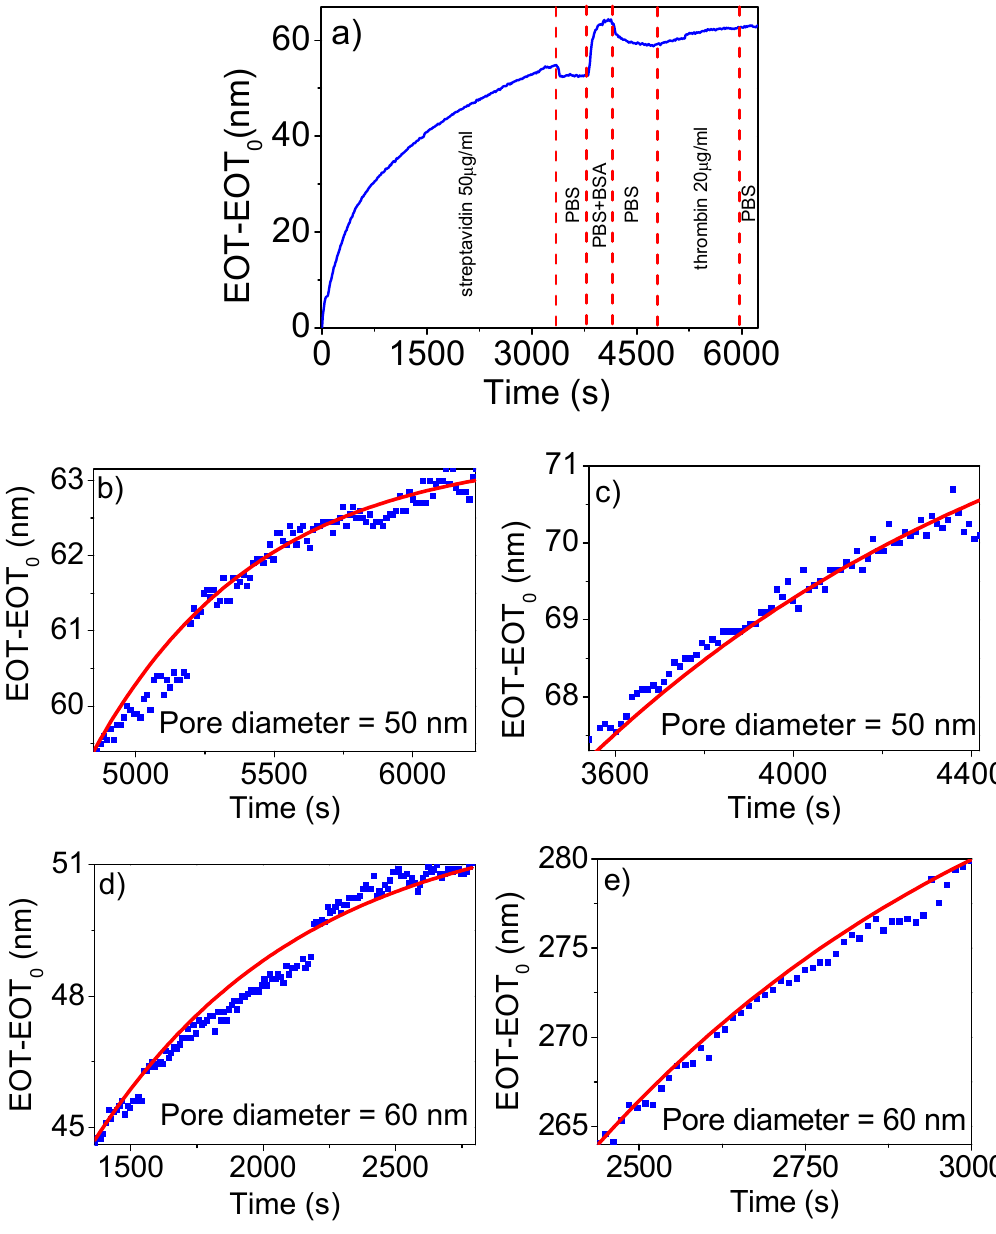
Figure 4. ( a ) Example of the registered change in EOT as a function of time for one of the performed biotinylated thrombin attachment experiments. ( b , c ) A close-up corresponding to the biotinylated thrombin step for two experiments corresponding to NAA with 50 nm pore diameter. ( d , e ) A close-up for the same step for two experiments corresponding to NAA with 60 nm pore diameter.